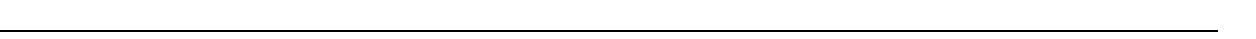
Fig. 2 Interaction of Dim2 with biogenesis factors of the 90S pre-ribosome. a ct Dim2 speci fi cally interacts with Utp1 (Pwp2) on the 90S pre-ribosome. Left panel: cryo-EM structure of the ct 90S pre-ribosome (PDB: 5JPQ) 7 highlighting the position of Krr1 (violet) and interacting proteins Rps14 (green) and Rps1 (pink) in the context of the 40S platform pre-rRNA, (light blue), as well as Dim2 (red) and interacting Utp1 (dark blue) in the context of the UTP-B oligomerization platform (orange). Right panel: Flag 3 - ct Utp1 and ProtA-TEV- ct Dim2 were co-expressed in yeast and tandem af fi nity-puri fi ed via the split- tag method. The fi nal eluate (E) was analyzed by SDS-PAGE (4 – 12%) and Coomassie staining. b Dim2 but not structurally related Krr1 interacts with Utp1 by 2-hybrid. Yeast 2-hybrid analysis of three individual transformants, harboring the indicated bait (BD) and prey (AD) plasmids. Transformants were analyzed by growth for 2 days at 30 °C on SDC-Leu-Trp (plating ef fi ciency) and SDC-Leu-Trp-Ade plates (strong interaction). SV40 and p53 served as negative controls. c Yeast strain GAL::scDIM2 with integrated sc Krr1-FTpA or sc Utp1-FTpA was grown in galactose (GAL) medium or shifted for 8 h to glucose (GLU) containing medium before the indicated bait proteins were tandem af fi nity-puri fi ed. TCA-precipitated Flag eluates were analyzed by SDS- PAGE (4 – 12%) and Coomassie staining (upper panel) or western blotting (lower panel) using the indicated antibodies. The indicated proteins were identi fi ed by mass spectrometry. Dashed box is a zoom of the respective gel region to better display the Dhr1 enrichment. d Semiquantitative mass spectrometry of the Krr1 – FTpA eluates from GAL::scDIM2 -expressing (GAL) and GAL::scDIM2 (GLU)-depleted cells (see Fig. 2c, lanes 1 and 2). The iBAQ (intensity-based absolute quanti fi cation) numbers derived from mass spectrometry analysis of the two different Krr1 – FTpA eluates were normalized to the iBAQ value of the Krr1 bait protein. The relative iBAQ ratios of co-puri fi ed 90S factors derived from depleted versus expressing Dim2 cells are displayed, with the numerical data shown in Supplementary Data 1. The experiments were performed at least twice with consistent results. Uncropped images are shown in Supplementary Fig. 9. S molecular weight protein